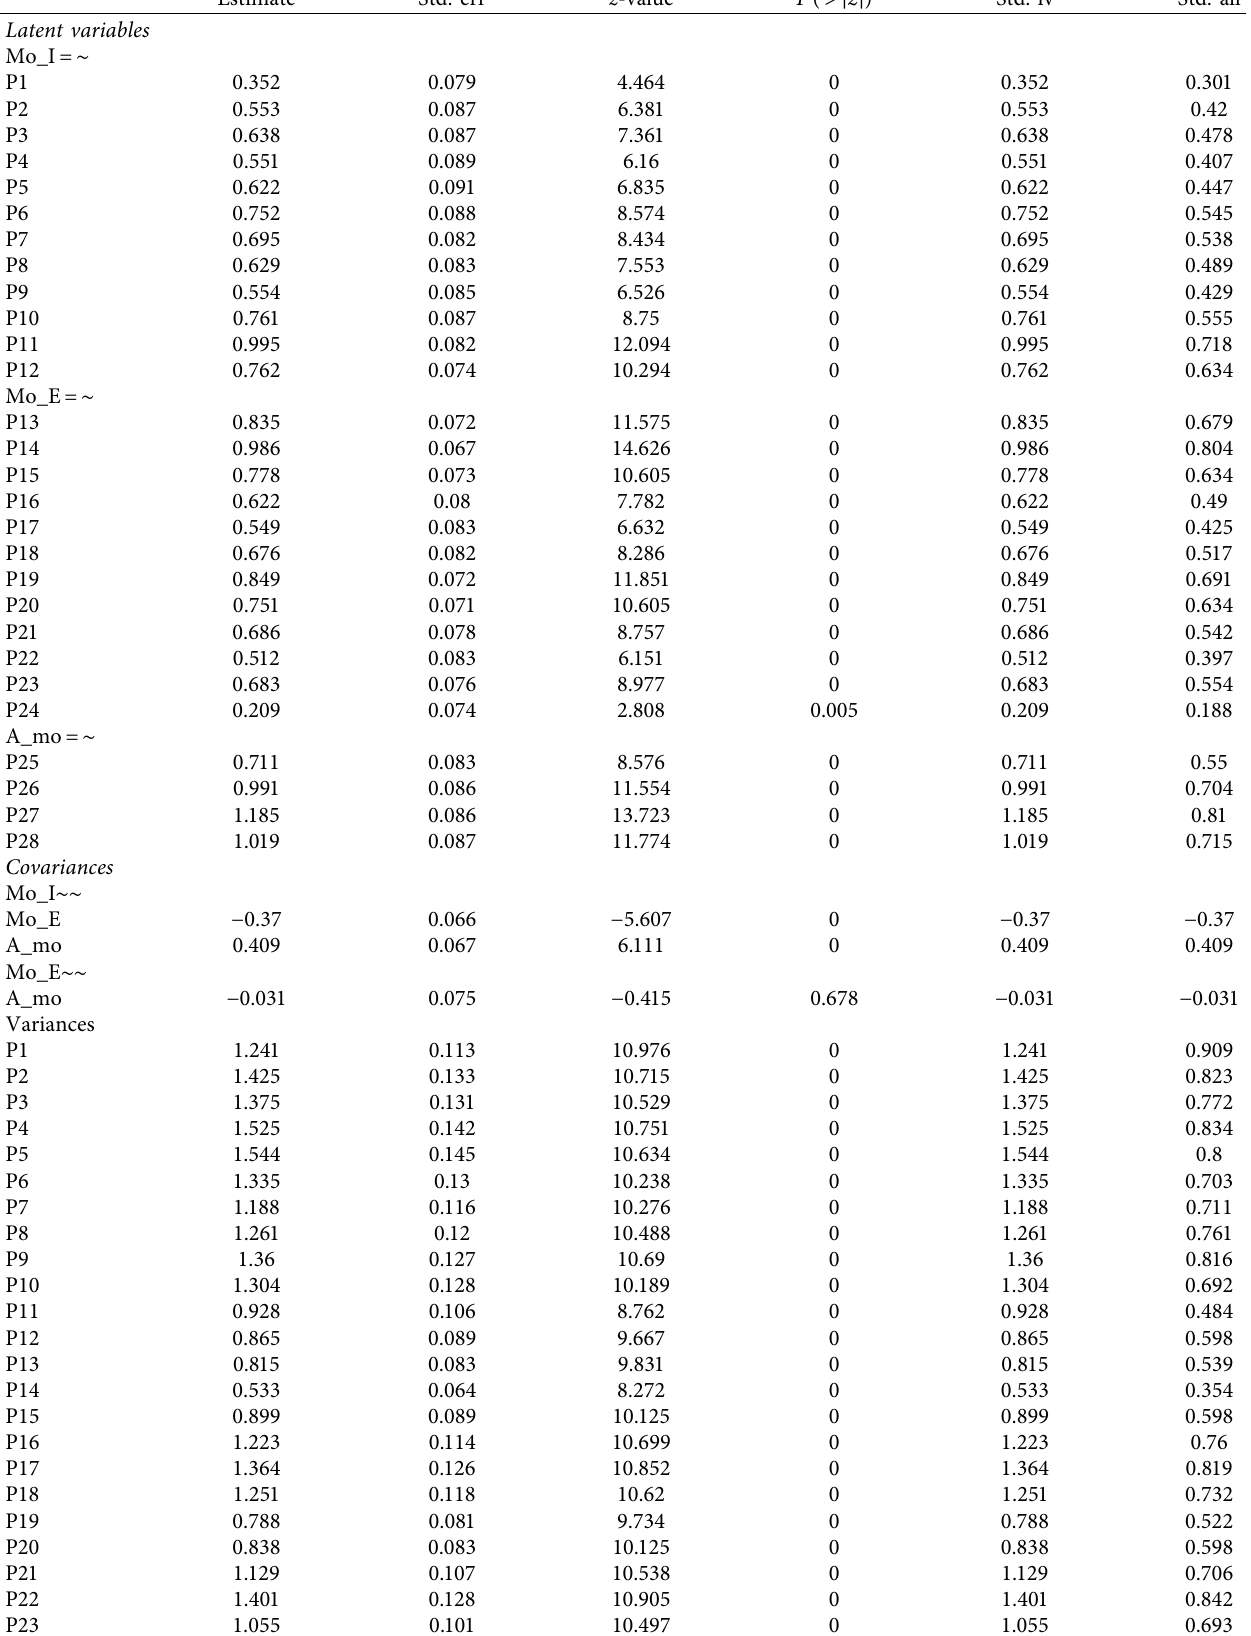
Table 2: Estimates of autovalues, correlations, and